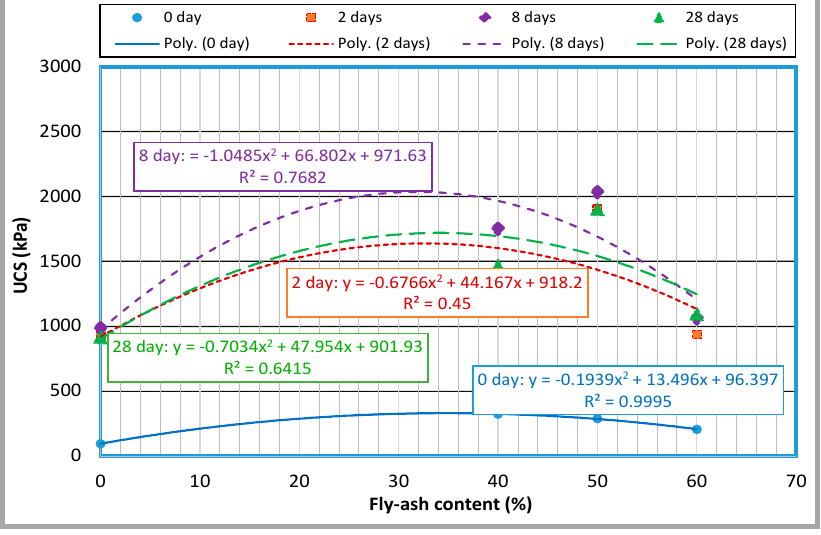
Figure 9. Variation of UCS with fly ash content with trend